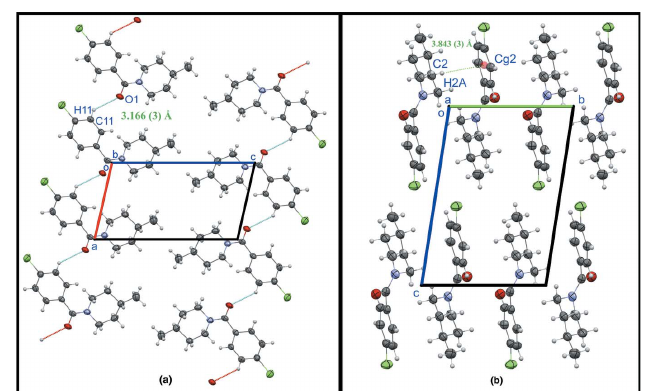
Figure 2 ( a ) The molecular packing viewed perpendicular to the ac plane, showing the formation of chains along the a axis. Dotted lines indicate weak C— H (cid:3)(cid:3)(cid:3) O interactions. ( b ) The crystal packing viewed along the a axis,